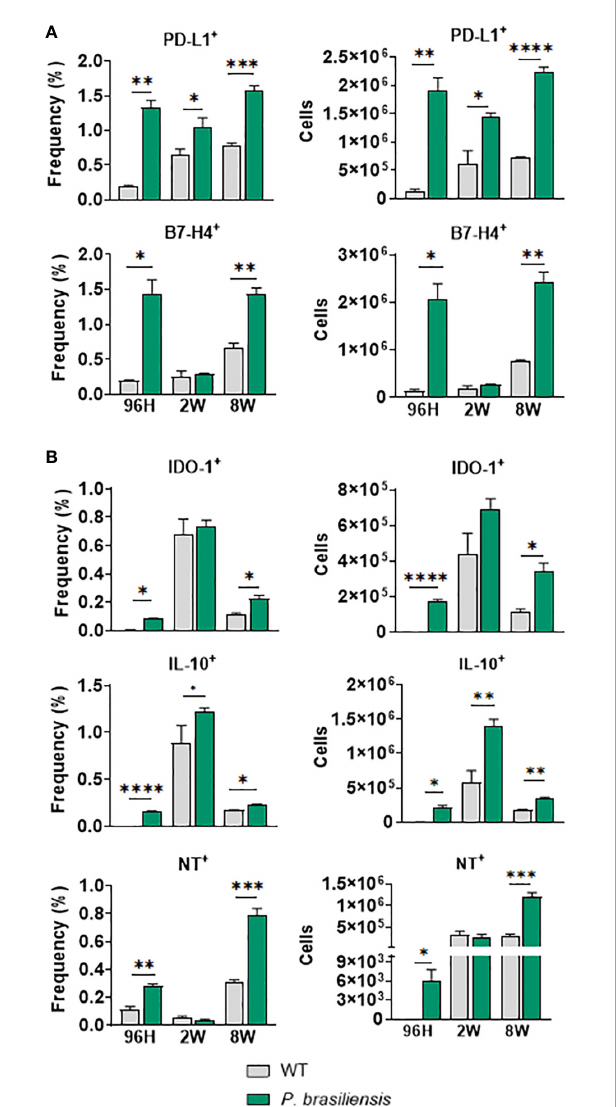
FIGURE 3 Immunosuppressive molecules expressed by Monocytic-like-MDSCs (M-MDSCs) in response to P. brasiliensis infection. The expression of immunosuppressive molecules by M-MDSC was evaluated in the lung in fi ltrating cells of P. brasiliensis -infected mice (1×10 6 yeasts cells) by fl ow cytometric analysis with 96 hours, 2 weeks, and 8 weeks of infection. The expression of cell membrane molecules (A) such as CD274 (PD-L1) and B7-H4, as well as intracellular molecules (B) IDO- 1, IL-10, and nitrotyrosine (NT), were evaluated in CD45 + CD11b + LY6G - LY6C hi cells (M-MDSC). Cells were gated by FSC/SSC analysis. Data represent three independent experiments with 3-4 mice each. For comparisons between two groups, the mean ± SEM was obtained and analyzed by the unpaired Student ’ s t -test. Differences were considered signi fi cant when: * p <0.05; ** p <0.01; *** p <0.001 and **** p